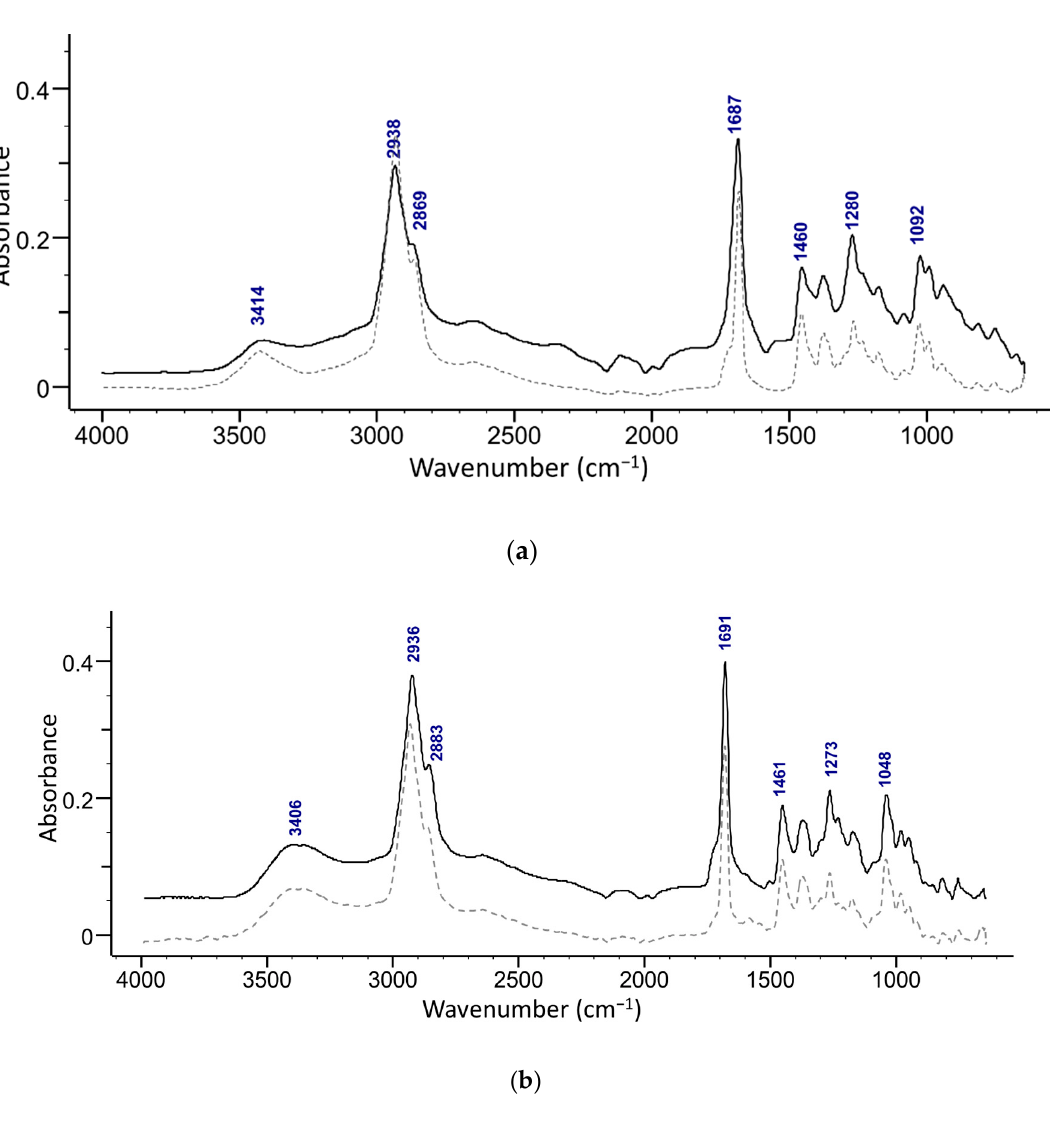
Figure 5. Superimposed ATR-FTIR spectra of ( a ) an isolated compound from combined 13–19 fractions from ethanol extract and oleanolic acid standard (dashed line), and ( b ) s compound isolated from the fractions 18–20 from the ethyl acetate extract and maslinic acid standard (dashed line).